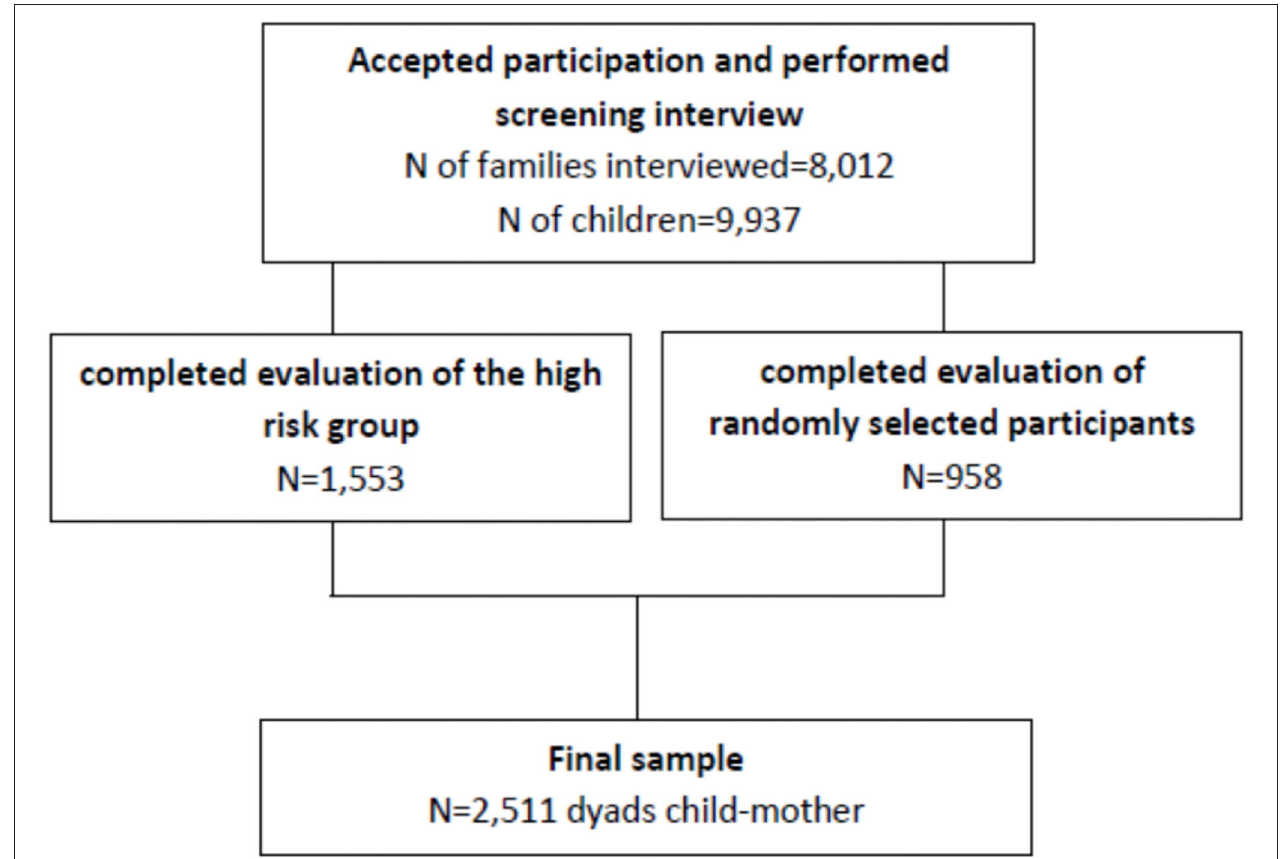
FIGURE 1 | Sample selection